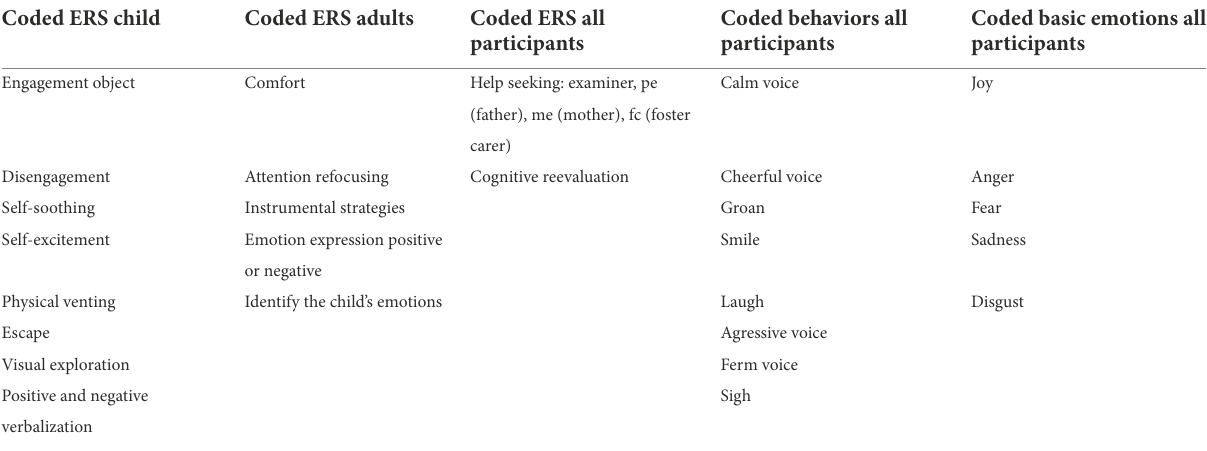
TABLE 1 Coded ERS and behaviors. Coded ERS